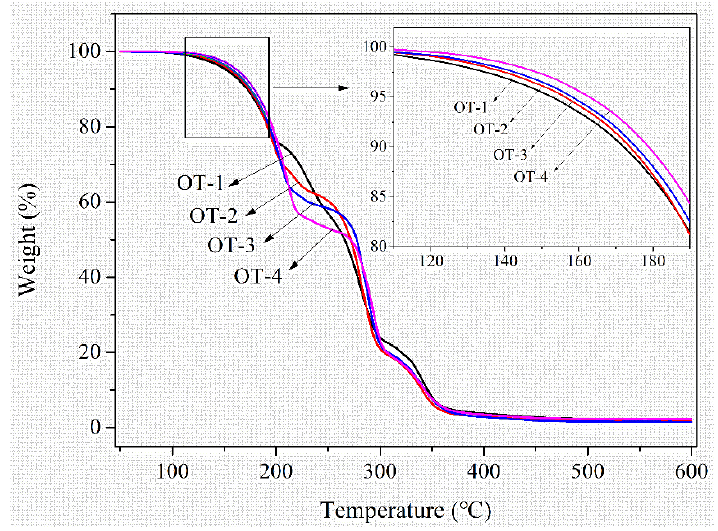
Figure 6. TGA curves of composite microcapsules with different OD to TO ratio. Table 2. The TGA results of pure cores and various composite microcapsules.